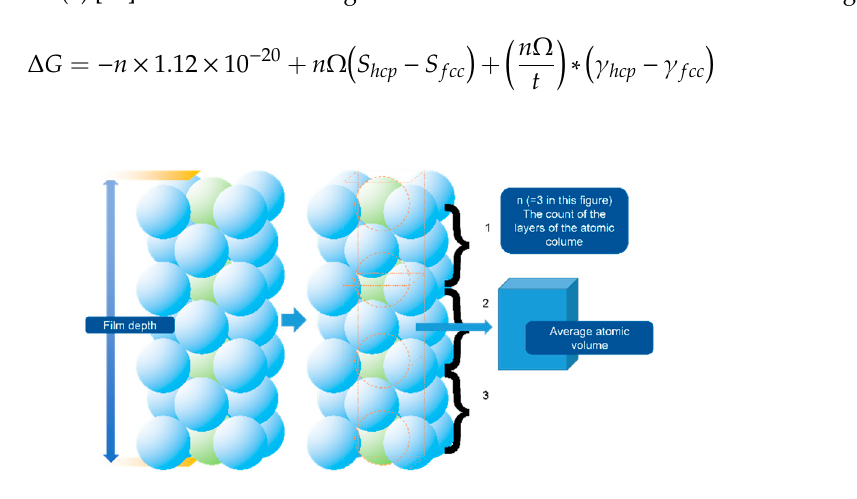
Figure 10. The instructions of the Δ G of the atomic column of the depth direction [30].